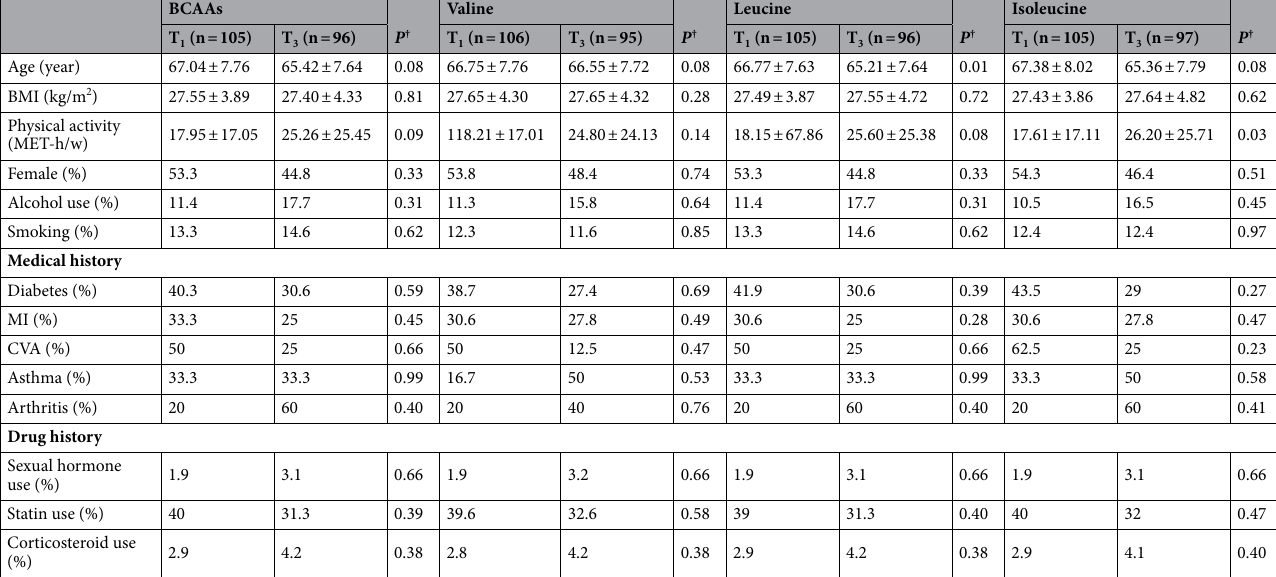
Table 3. General characteristics of study participants across tertile categories of BCAAs. All values are mean ± SD, unless indicated; † ANOVA for continuous variables and Chi-squared test for categorical variables. BCAAs branched-chain amino acids, BMI Body mass